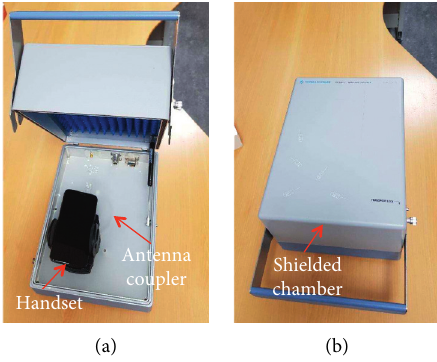
Figure 4: Shielded chamber with (a) open and (b) closed lid. Table 1. Most of the earbuds show distinct differences in the